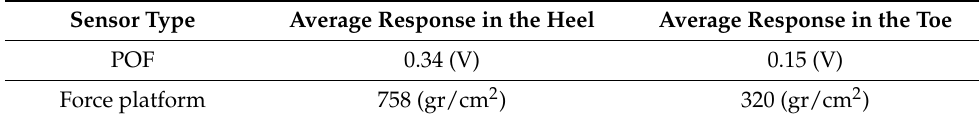
Figure 8. The position of the sensors on the heel and toe part of the insole which are related to the point with higher pressure in the sole of the foot. Table 1. Response of the force platform and POF sensor at heel and toe.